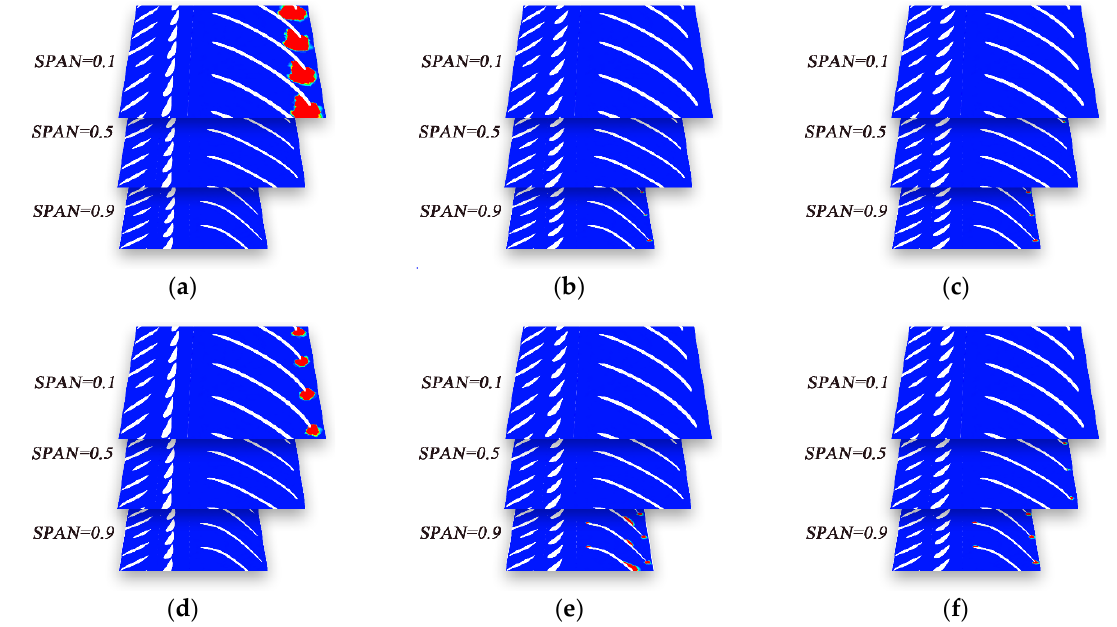
Figure 5. Cavitation volume fractions at rated head and maximum head. ( a ) OP1, ( b ) OP2, ( c ) OP3, ( d ) OP4, ( e ) OP5, and ( f ) OP6.